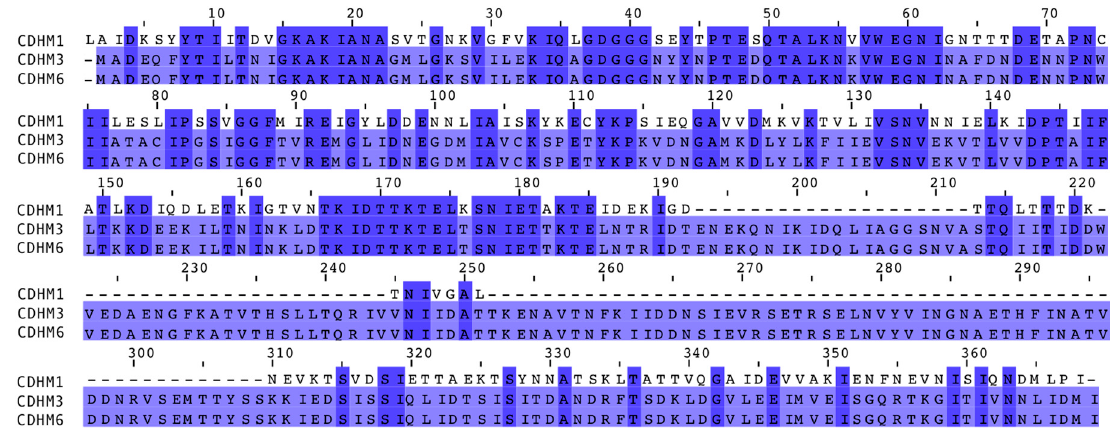
Figure 2. Alignment of putative tail fiber protein sequences of C. difficile phages CDHM1, CDHM3 and CDHM6. The alignment tool MUSCLE was used and gaps in the sequence are indicated with dashed lines and numbers above mark the amino acid number. The length of each sequence was 267, 368 and 368 amino acids for phages CDHM1, CDHM3 and CDHM6 respectively. The color of the amino acid represents its percentage identity to the consensus sequence, where the darker the color the higher the percentage identity.